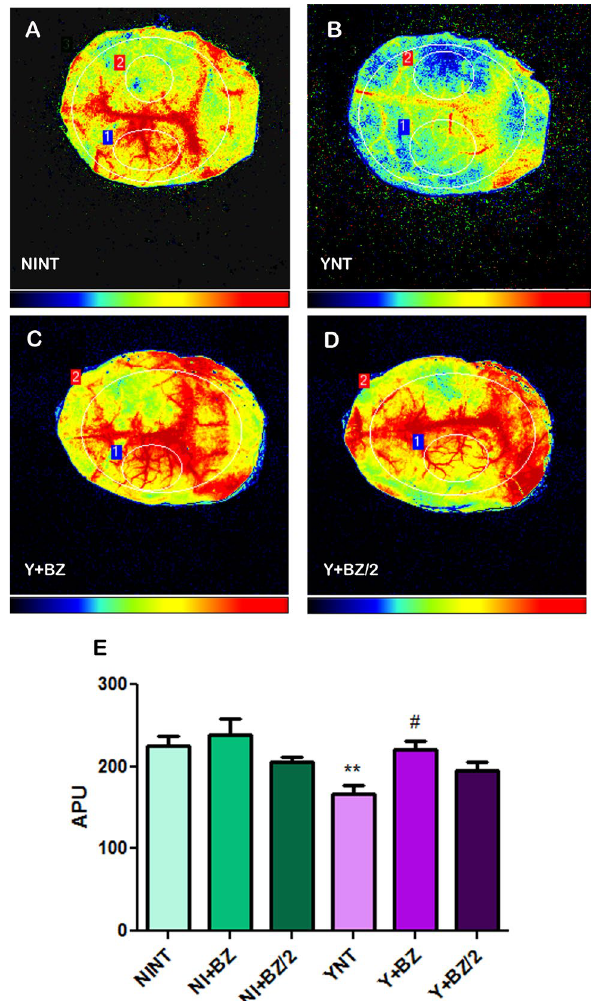
Figure 4. Analysis of cerebral blood flow by fluxometry at 15 dpi, showing decreased cerebral blood flow in the YNT group ( B ) when compared to NINT group ( A ). Treatments with BZ ( C and D ) prevented this decrease. Graphic indicates brain blood flow through arbitrary perfusion unit (APU) ( E ). NI, non infected; Y, infected; NT, non treated; BZ, treated with benznidazole (100 mg/kg/day); BZ/2, treated with benznidazole (50 mg/ kg/day); dpi, days post-infection. *when compared to NINT; #when compared to YNT *p < 0.05, **p < 0.01, ***p <